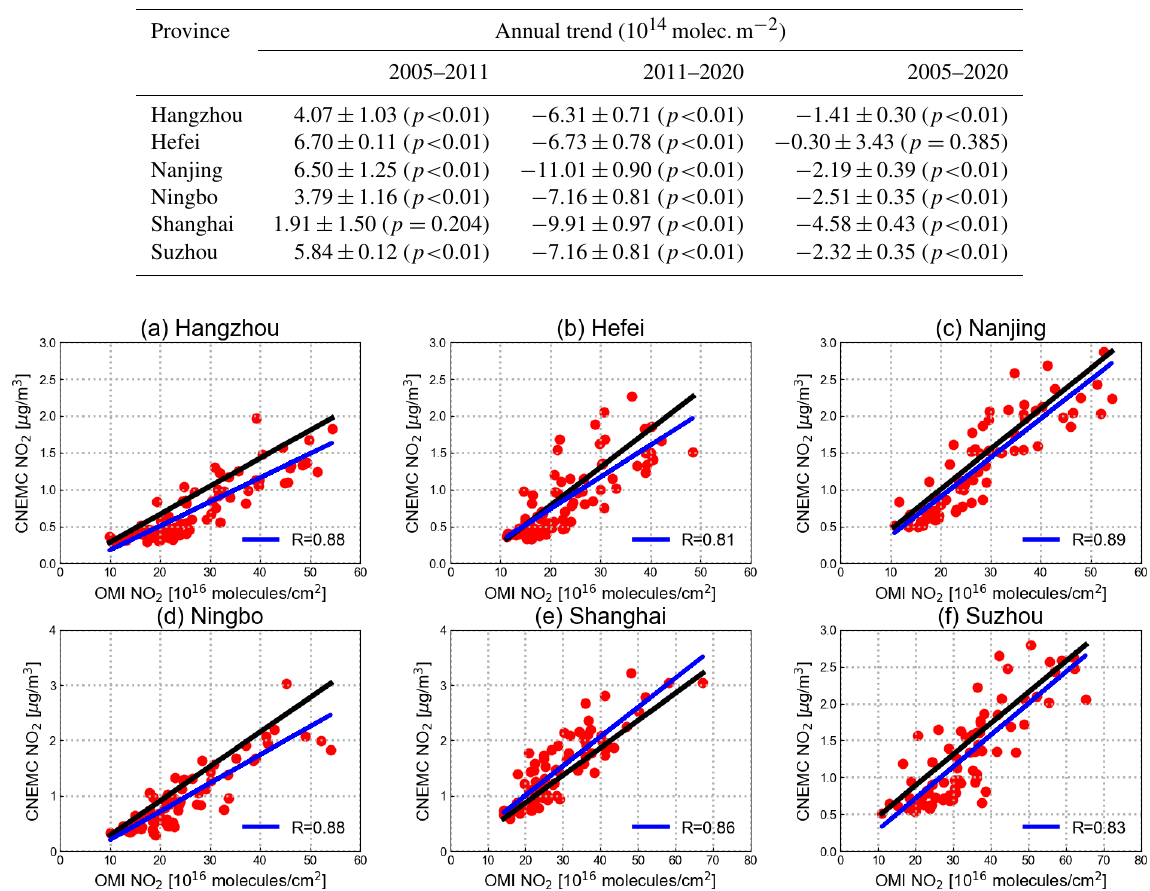
Figure 4. Correlation of OMI NO 2 VCD trop against ground-level observations data over Hefei, Nanjing, Shanghai, Suzhou, Hangzhou, and Ningbo. We fitted both datasets directly without unifying their units, which does not affect the investigation with respect to the agreement of the two datasets in terms of variabilities. Blue lines are linear fitted lines, and black lines are the 1:1